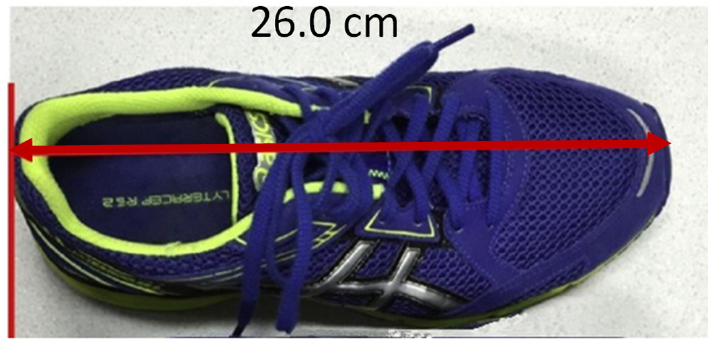
Figure 5. The running shoe used for the experiment (adapted from